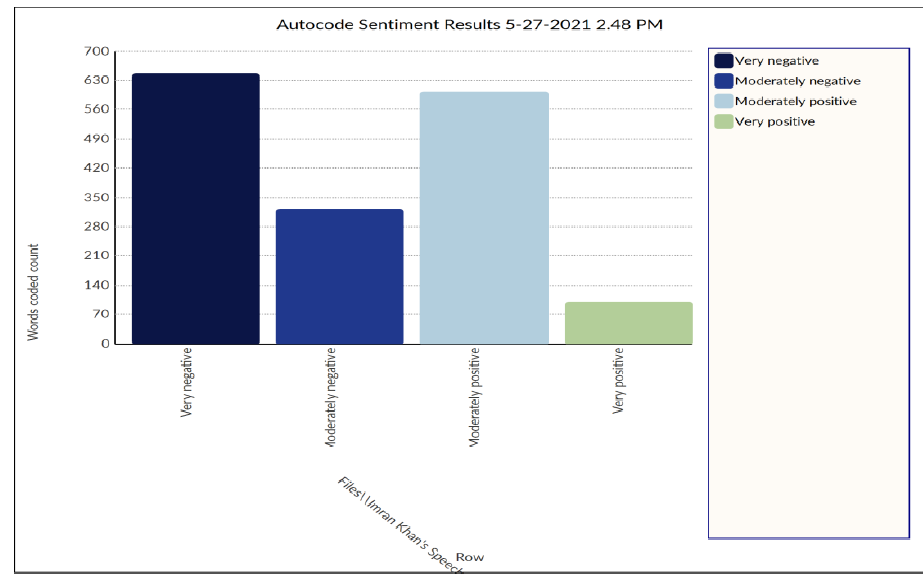
Figure 3. Sentiment chart of Imran Khan’s speech.